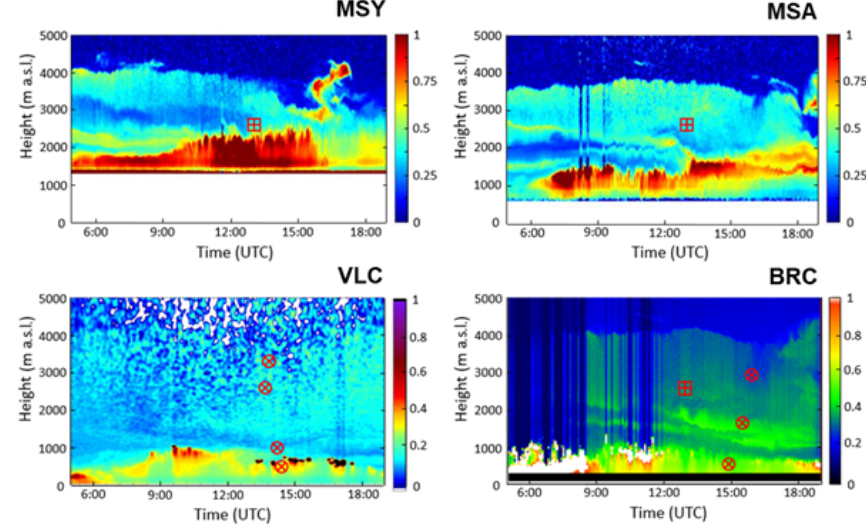
Figure 25. Time series of range-corrected lidar signals from ground-based remote sensing measurements in MSY, MSA (both at a wavelength of 1064nm), VLC (910nm), and BRC (532nm) on the 28 July 2017. Depicted are the signal strengths relative to the maximum signal of the corresponding measurement. Red circles show time and altitude of the HALO overpasses used for the comparison of airborne with ground-based remote sensing measurements (see Figs. 26 and 27). Red squares show further HALO overpasses.